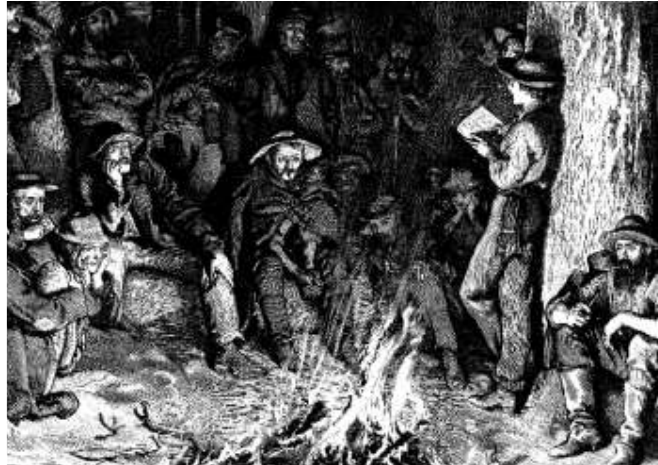
Figure 1 Book culture under conditions of American West in the mid-19 th century. This image illustrates a poem published by Bret Harte in 1904, titled “Dickens in Camp.” It imagines one possible moment in the sensational American reception of Dicken’s Old Curiosity Shop (e.g., see: Garber 2013) . In this case, it shows laborers camped in the American West, listening to the story of little Nell with rapt attention. It is difficult to imagine reading and the book playing such a role among similar strata of American (or Western) society today. Licensed from